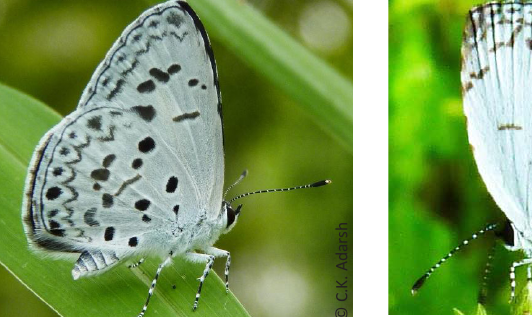
Image 67. Neopithecops zalmora Quaker